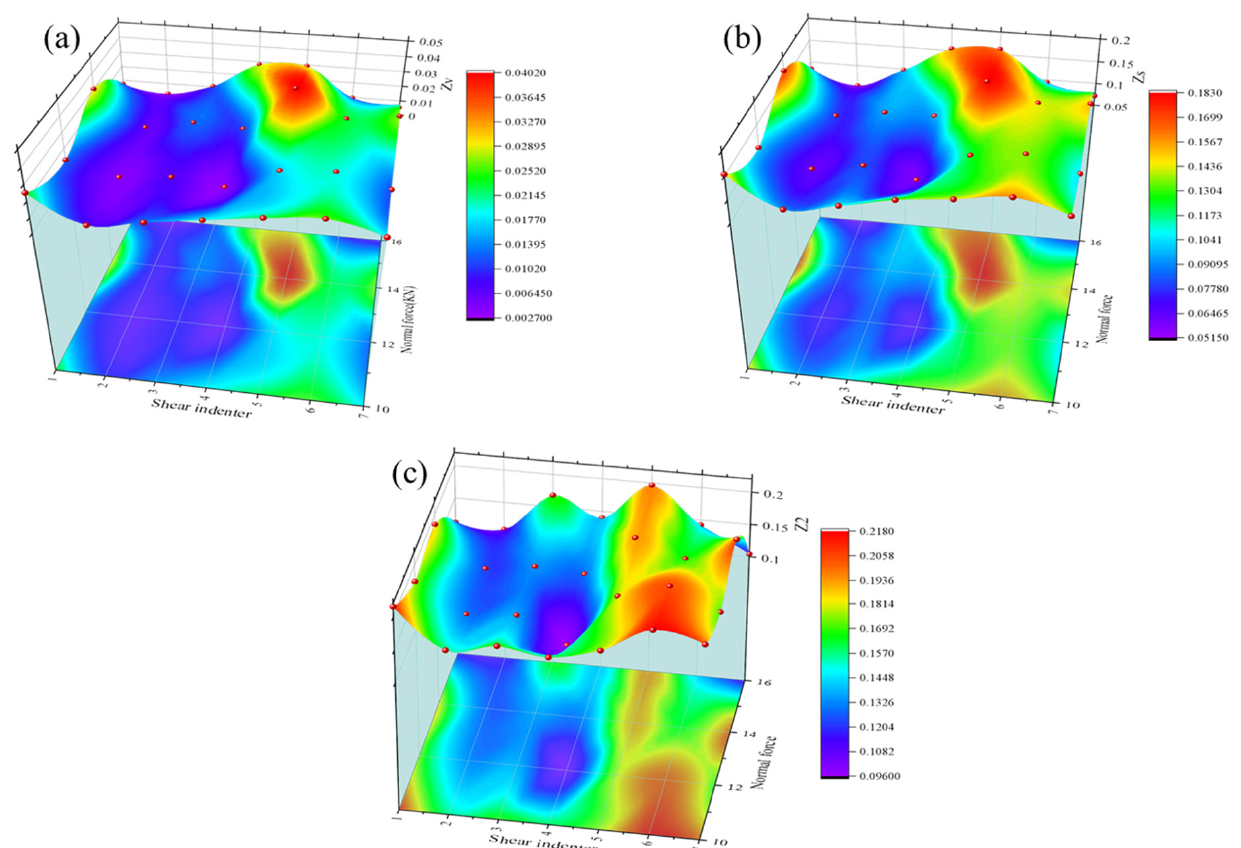
Figure 16. 3D clouds of characteristic parameters in the pressed-in area for different shear indenters and normal forces: ( a ) Z v ( b ) Z s ( c ) Z 2.